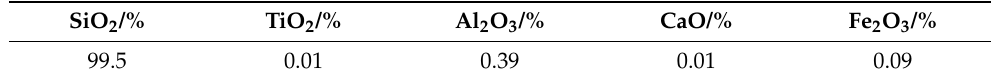
Table 1. The composition of silica powder.